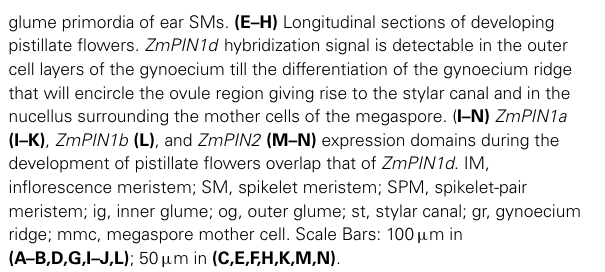
FIGURE 8 | Continued PIN transcripts localization pattern in maize